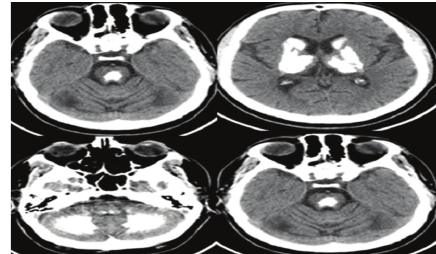
Figure 1: Brain computerized tomography (CT) scan: amorphous calcifications were detected in the bilaterally centrum semiovale, basal ganglia, capsula interna, thalami, mesencephalon, pons and bulbus, and the bilateral cerebellar